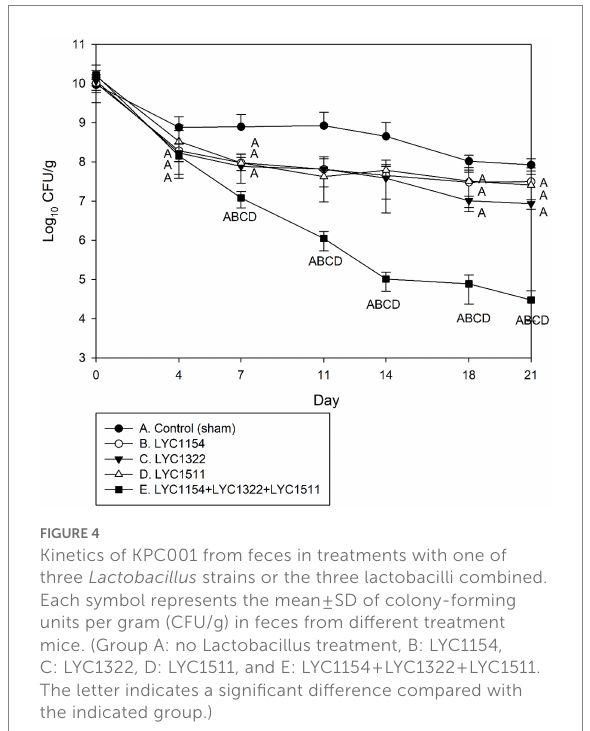
FIGURE 4 Kinetics of KPC001 from feces in treatments with one of three Lactobacillus strains or the three lactobacilli combined. Each symbol represents the mean ± SD of colony-forming units per gram (CFU/g) in feces from different treatment mice. (Group A: no Lactobacillus treatment, B: LYC1154, C: LYC1322, D: LYC1511, and E: LYC1154 + LYC1322 + LYC1511. The letter indicates a significant difference compared with the indicated